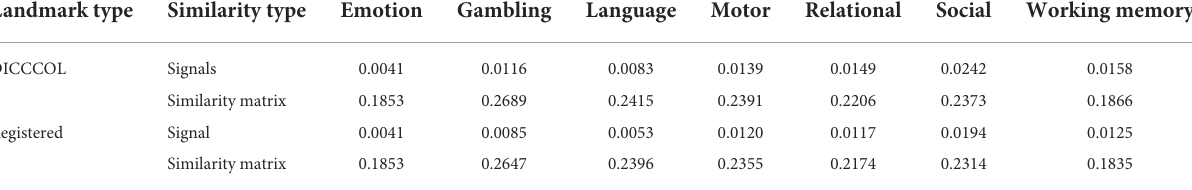
TABLE 6 Similarity comparison between DICCCOL-based and traditional registration